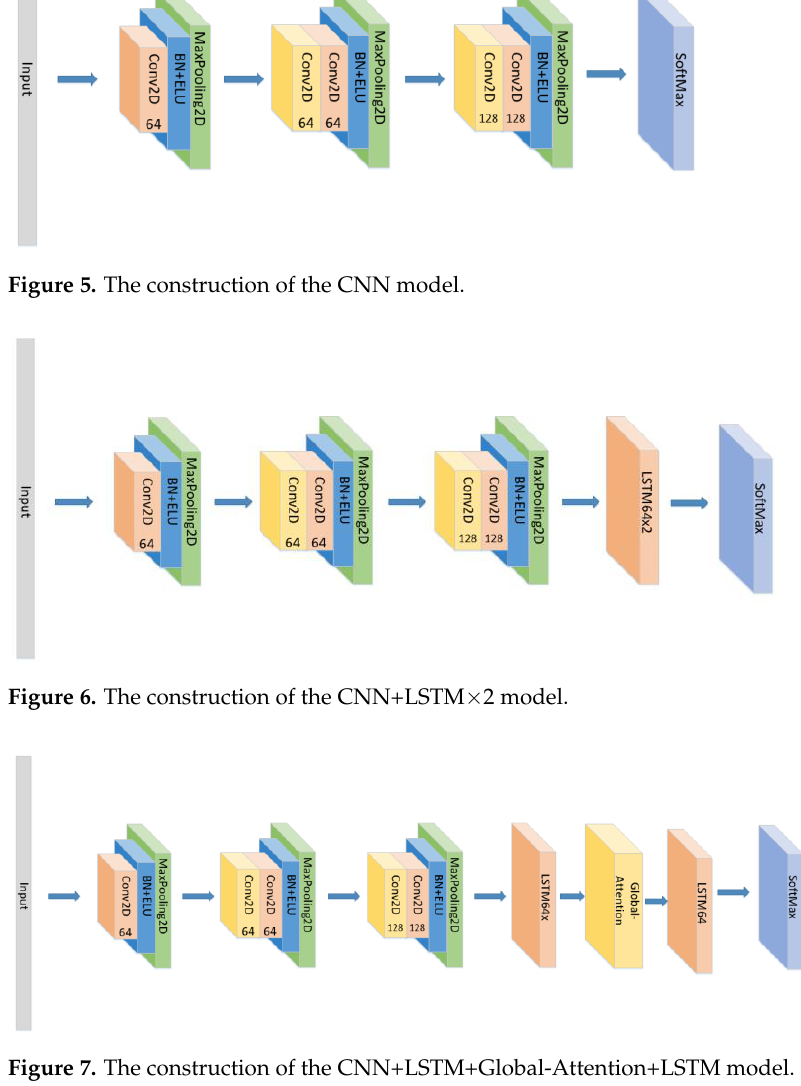
Figure 8. The construction of the CNN+LSTM×2+Self-Attention model. (5) The position of the attention mechanism was changed as seen in Figure 9, and the CNN+LSTM+Self-Attention+LSTM network with the same parameters as the original model was set to explore the influence of the form of attention on the accuracy of the model. Figure 9. The construction of the CNN+LSTM+Self-Attention+LSTM model. (6) Set the CNN network with the same parameters and the same number of layers as the original model with the Self-Attention as shown in Figure 10.